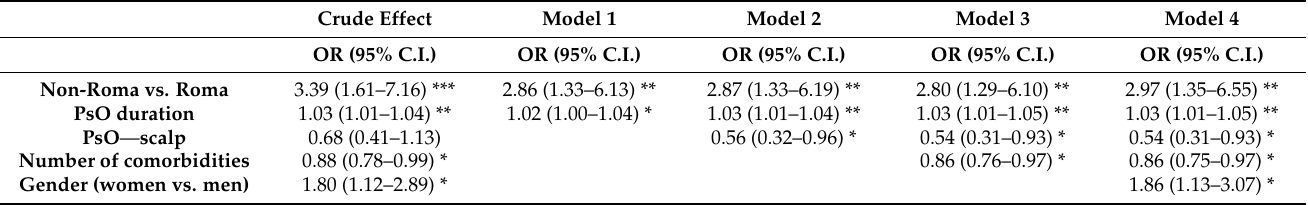
Table 7. Logistic regression models testing the crude and adjusted effects of four variables on being vaccinated (at least once) against COVID-19, cumulatively adjusted in four models.